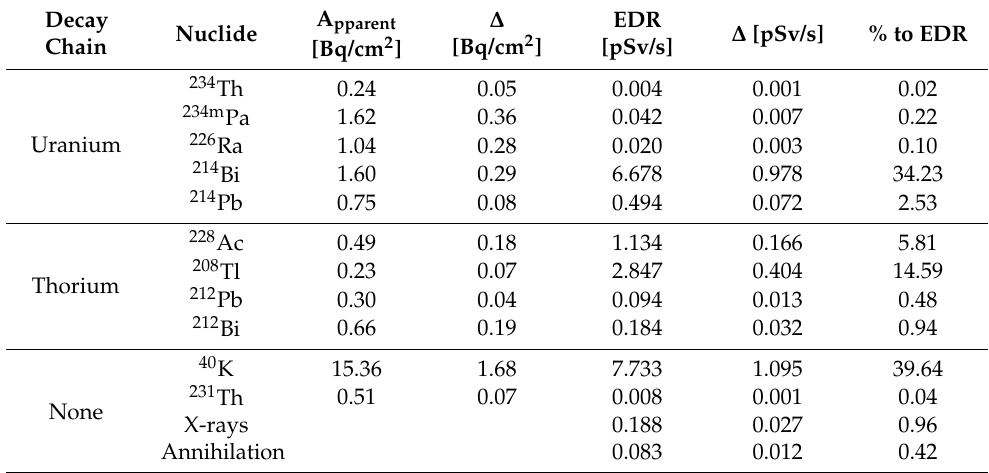
Table 1. Apparent activity in [Bq/cm 2 ], effective dose rate (EDR) in [pSv/s], with the calculated contribution (%) of each isotope to EDR estimated based on registered in situ gamma-ray spectrum. Uncertainties (denoted as ∆ ) are also